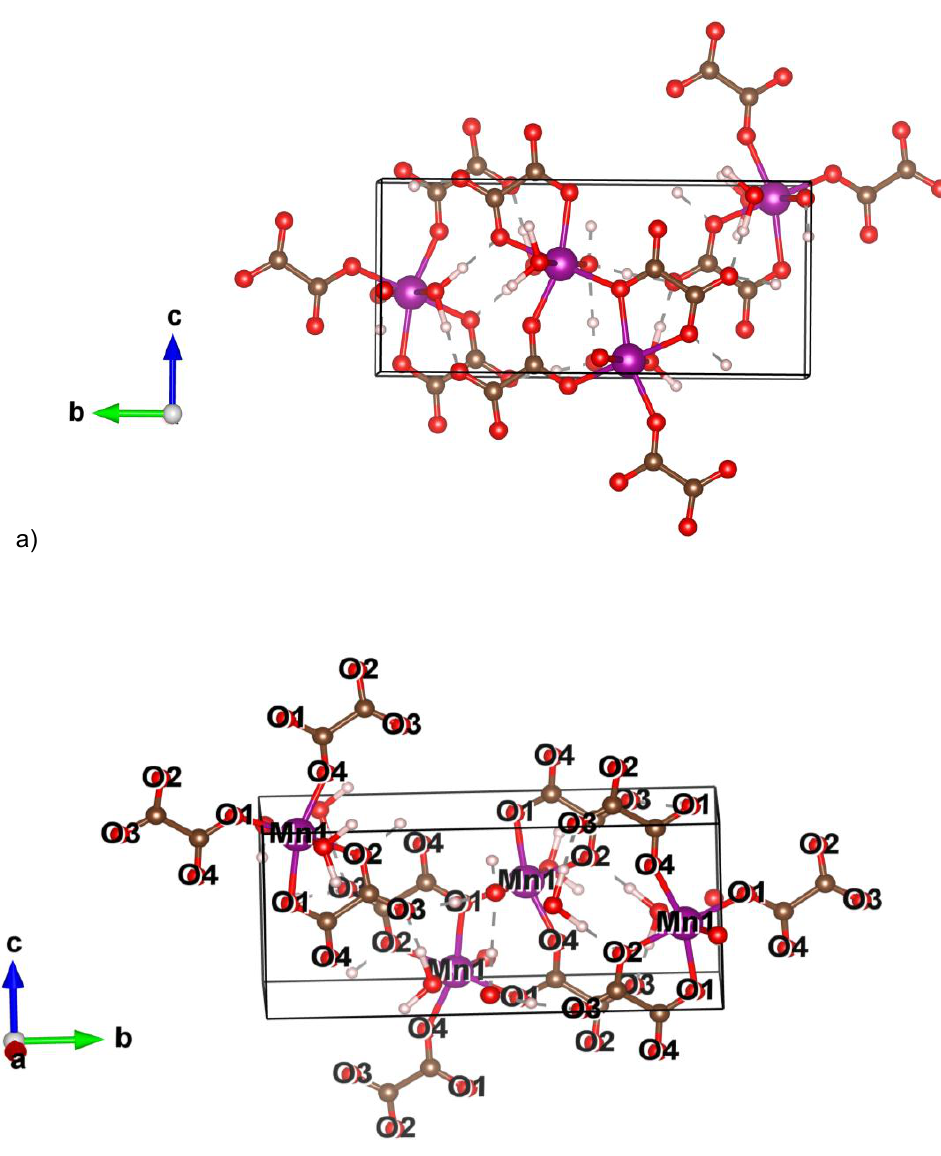
Figure 2: Molecular structure of g- MnC Table 3: Sel ected bond lengths (A˚) for  - MnC SELECTED BOND LENGTH S (A˚)